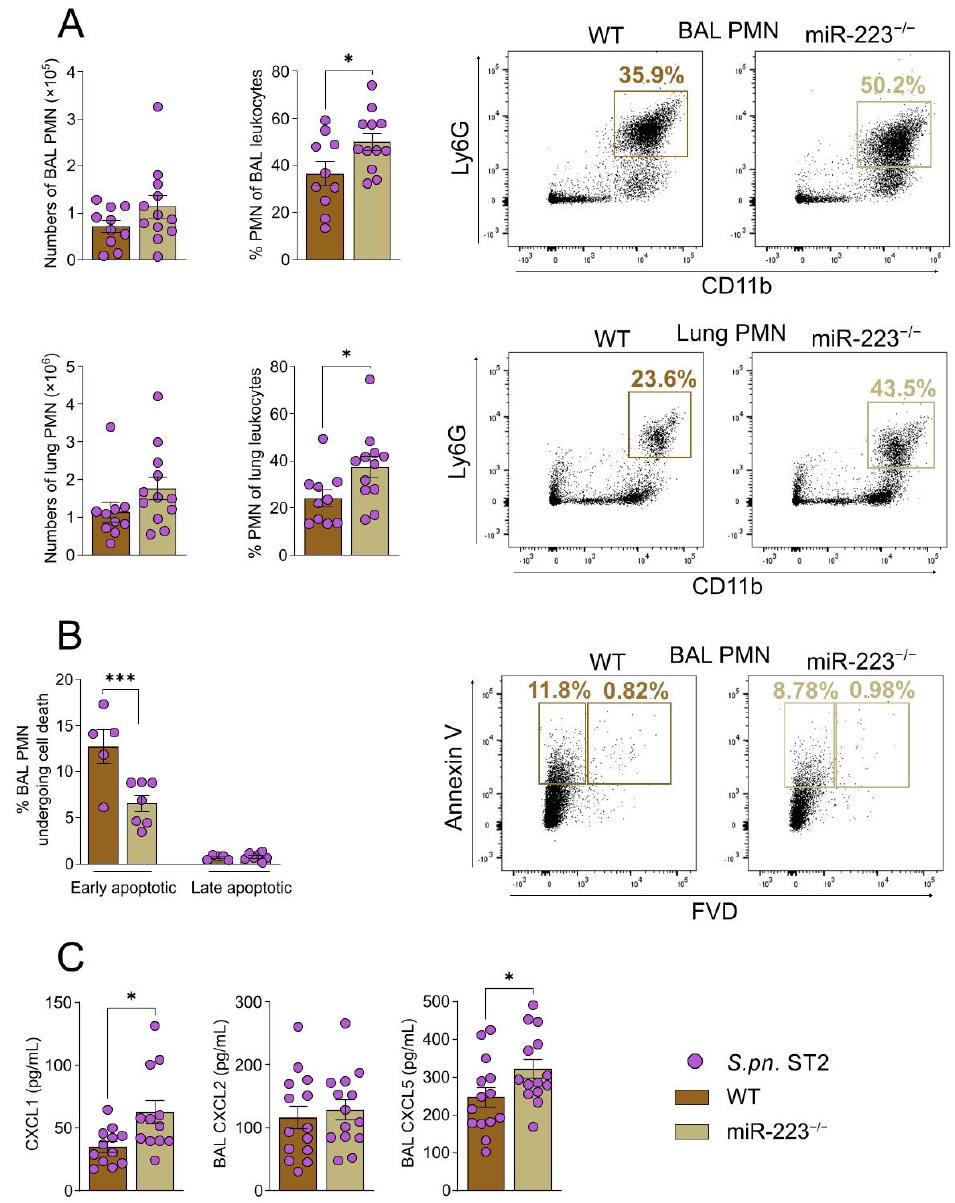
Figure 3. Absence of miR-223 leads to an enhanced and prolonged PMN response in the lungs and BAL of miR-223 − / − mice post- S.pn. ST2 infection. ( A ) PMN numbers, frequencies and representative dot plots in BAL and lungs 48 hpi ( n = 10–12). ( B ) Frequencies and representative dot plots of BAL and lung PMN undergoing early and late apoptosis 48 hpi ( n = 5–7). (C) CXCL1, CXCL2, CXCL5 chemokines quantified in the BAL of mice through ELISA 48 hpi ( n = 10–14). ( A , C ) Unpaired t -test; * p < 0.05. ( B ) 2-way ANOVA/Šid á k’s multiple comparisons test; *** p < 0.001. Data display individual values and means, error bars represent SEM. PMN: polymorphonuclear neutrophil, BAL: bronchoalveolar lavage, S.pn. ST2: Streptococcus pneumoniae serotype